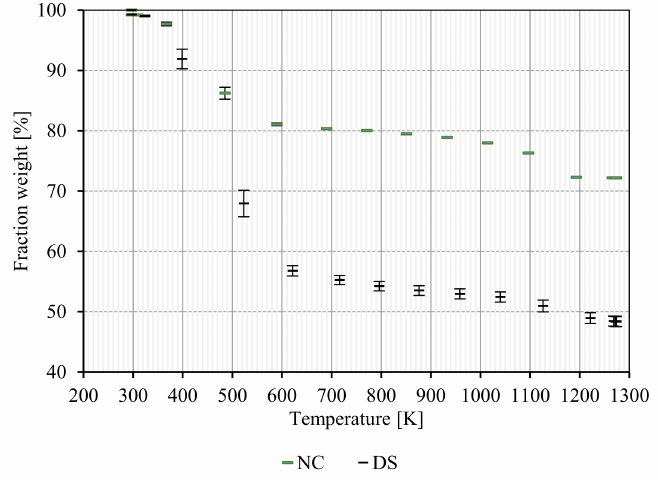
Figure 3. Mass changes of the raw materials when heated with a heat rate of 20 K min − 1 from ambient temperature till 1273 K, in air atmosphere.